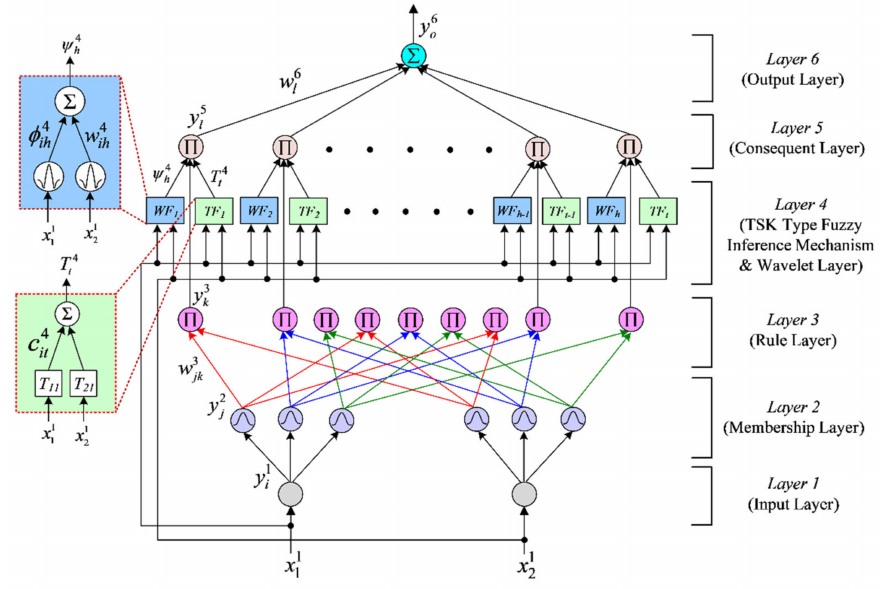
Figure 3. Network structure of WTSKFNN